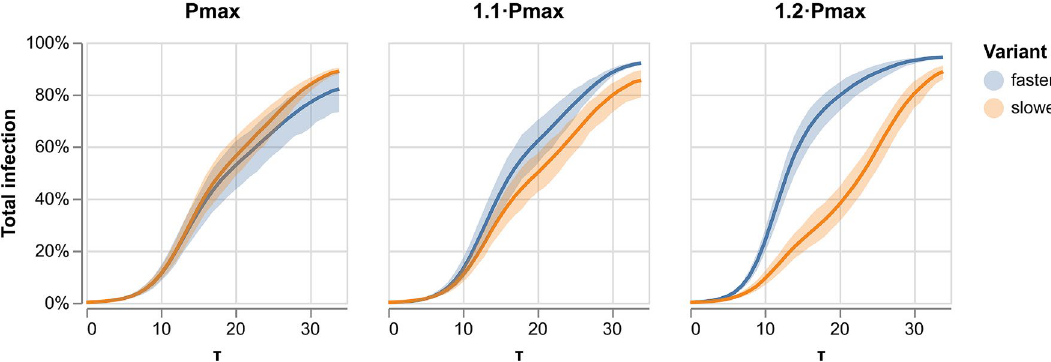
Figure 4. Competition between variants with no cross-immunity. Left panel: similar variants. Middle panel: faster variant is 1.1 times more probable to infect. Right panel: faster variant is 1.2 times more probable to infect.